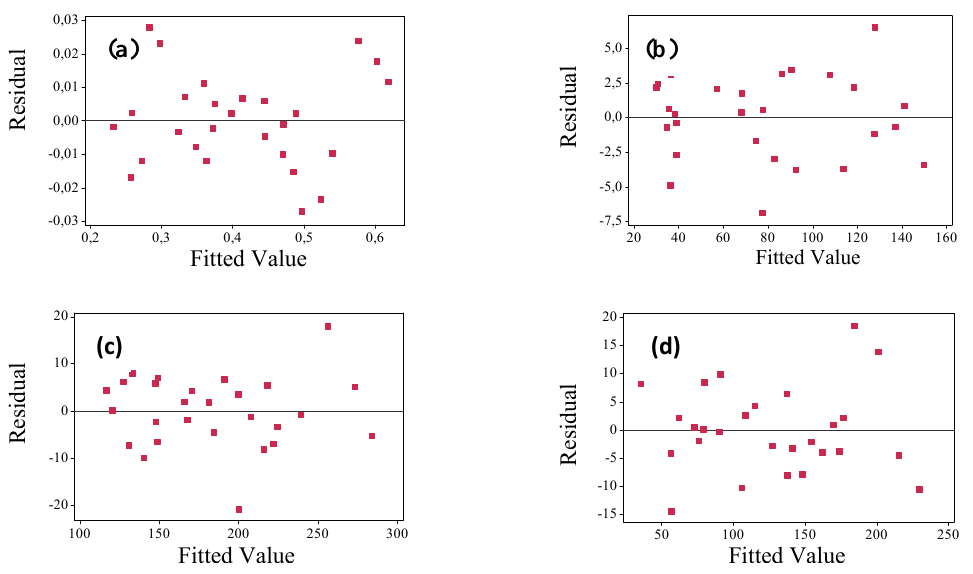
Fig.7. Plot of residuals vs. Fitted values for (a) Ra , and for (b) Fa , (c) Fr and (d) Ft, respectively